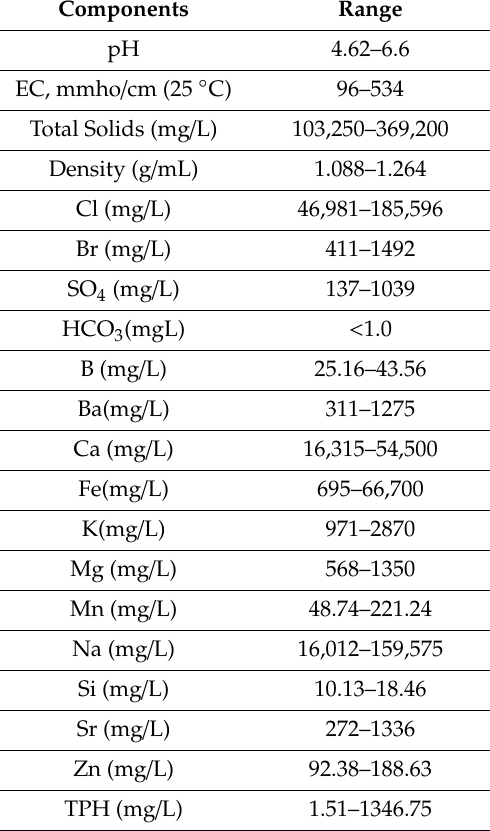
Table 1. Properties of brine (B: boron, Ba: barium, BCl: chloride, Br: bromide, Ca: calcium, EC: electrical conductivity, Fe: iron, HCO3: bicarbonate, K: potassium, Mg: magnesium, Mn: manganese, Na: sodium, Si: silicon, SO4: sulfate, Sr: stontium, TPH: total petroleum hydrocarbon, Zn: